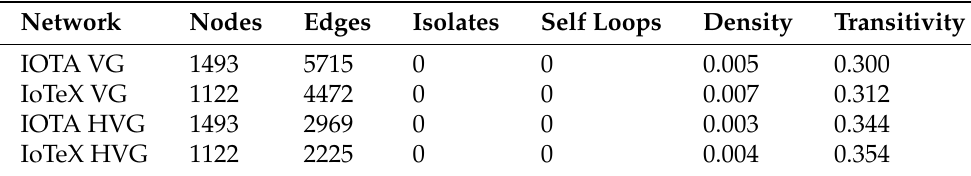
Table 9. Initial description of the visibility graph-based